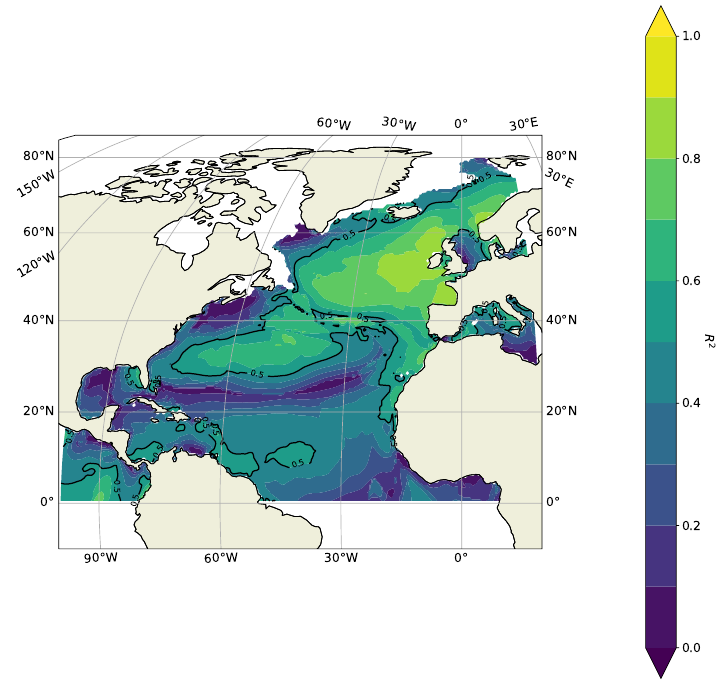
Figure 8. Coefficient of determination ( R 2 ) of all climate modes (i.e., NAO, EA, SCA, EA/WR, PNA, TNH, ENSO, SAM and WEPA) significantly correlated with JFM H s (see Figure 7). Values close to 1 (to 0) indicate that the JFM H s variance is well (poorly) explained by the sum of the studied climate modes. The black contour line shows where the 0.5 contour